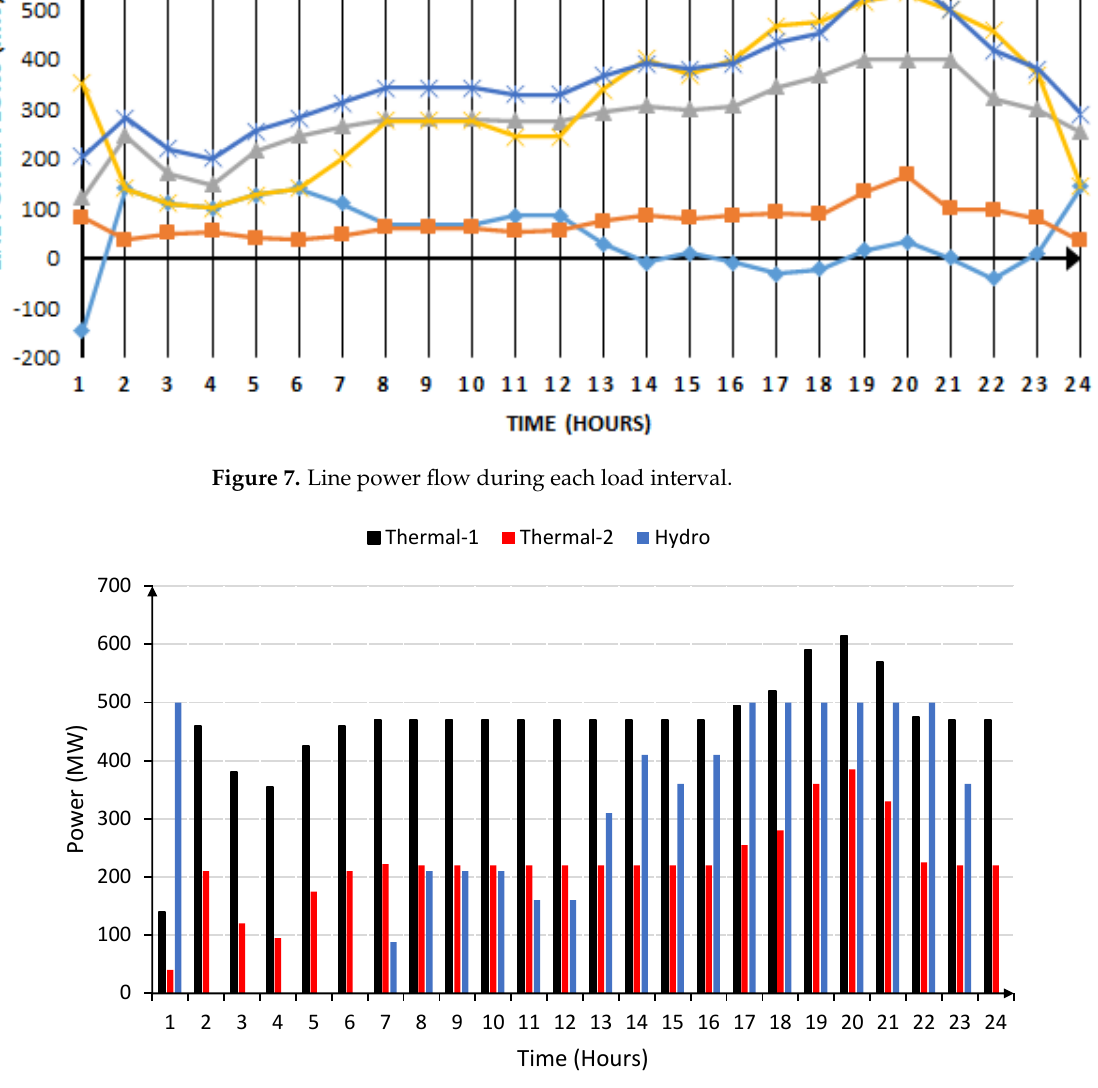
Figure 8. Generators optimal power during each load interval in infinite line capacity.